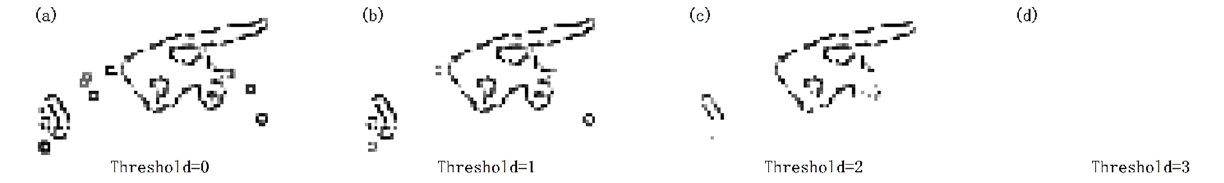
Figure 4. Comparison of different extraction results produced by the canny operator under four different threshold settings. ( a ) edge extraction results when the threshold is 0; ( b ) edge extraction results when the threshold is 1; ( c ) edge extraction results when the threshold is 2; and ( d ) edge extraction results when the threshold is